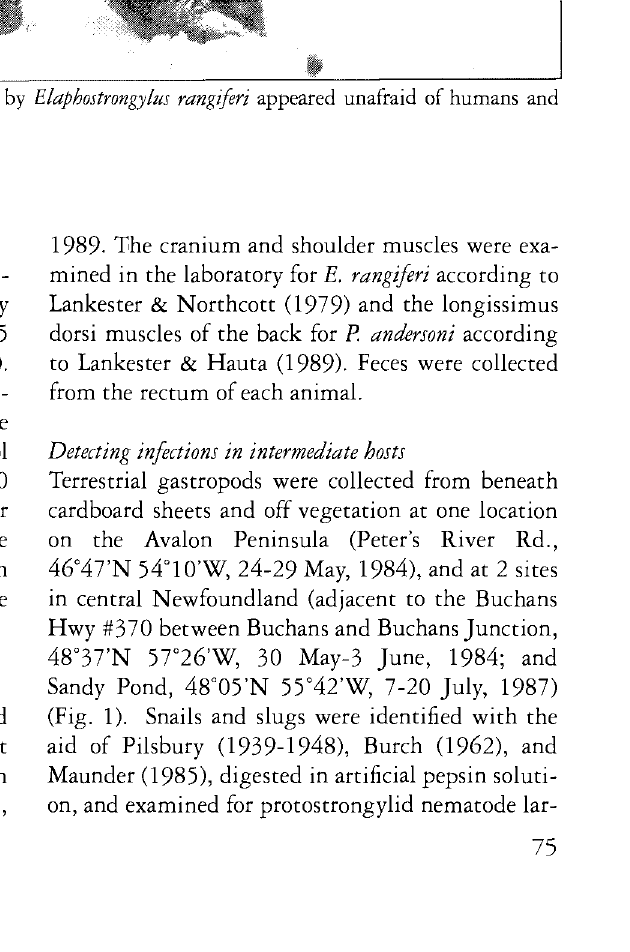
Fig. 2. Male caribou calf with posterior paresis caused by Elaphostrongylus rangiferi appeared unafraid of humans and could be easily approached and